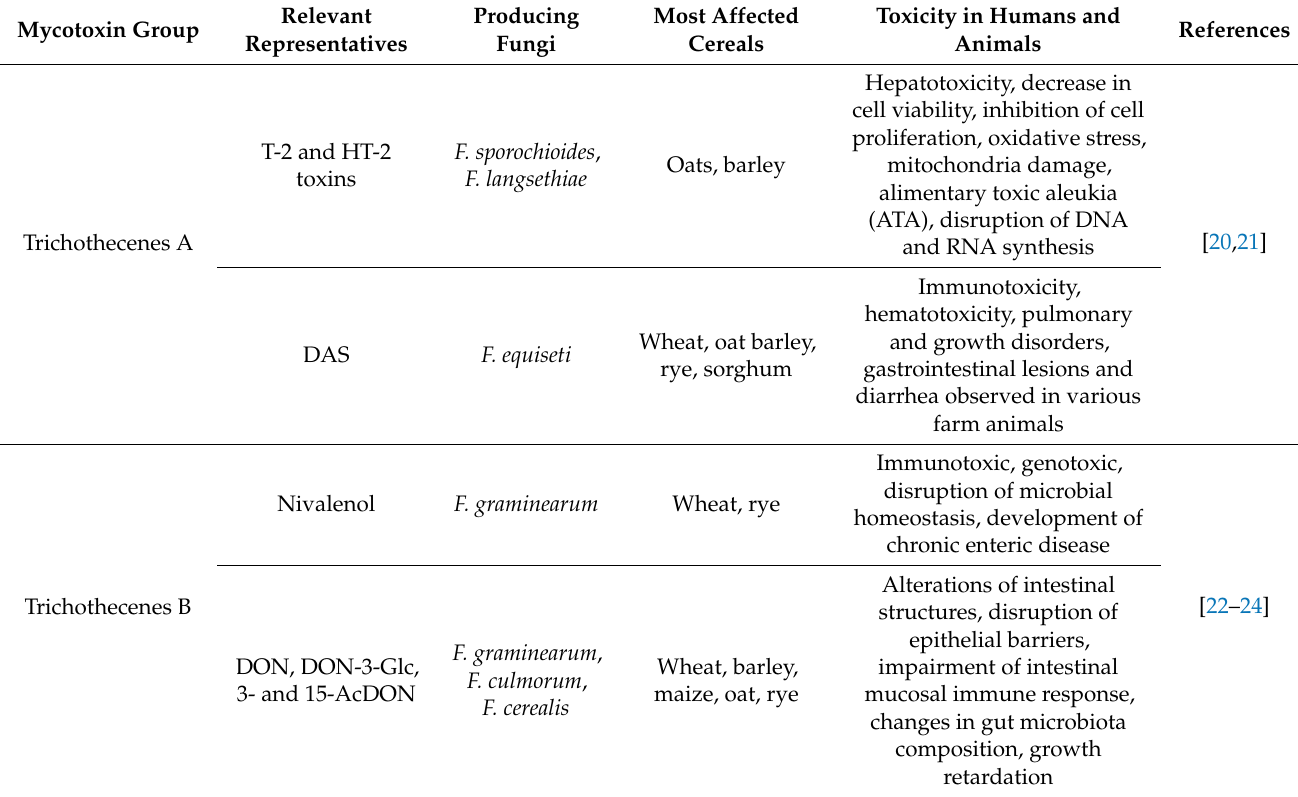
Table 1. Toxicity of Fusarium mycotoxins relevant for malt and